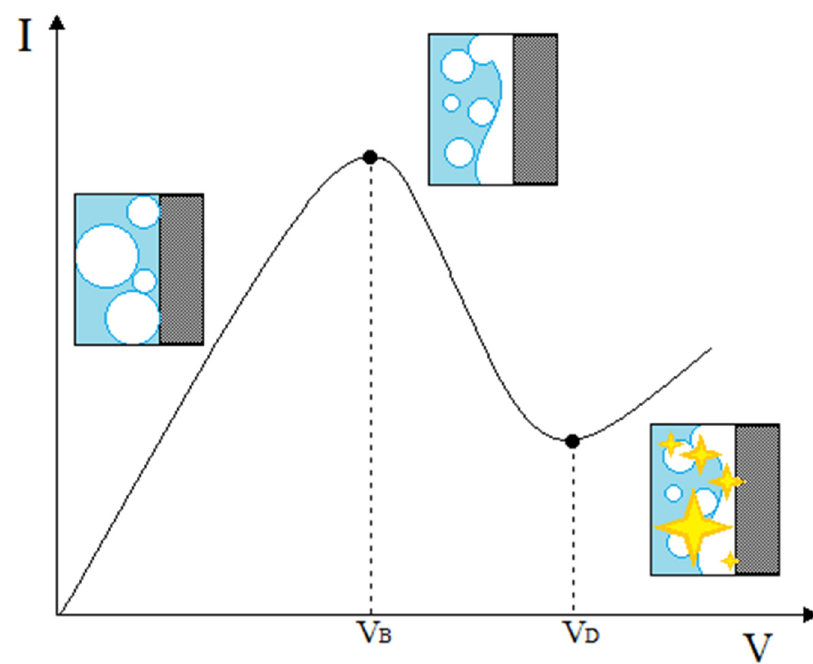
Figure 1. Individuation of V B and V D in a typical current–voltage characteristic curve of a contact glow discharge electrolysis (CGDE) experiment. From zero to V B voltage, the electrolysis proceeds with the current increasing in a nonlinear fashion as expected for a faradaic regime. This initial portion of the curve is associated with the formation of gas bubbles. Once the V B value is surpassed, the water vapor (formed because of Joule heating) plus the electrolytic gas coalesce to form a layer surrounding the active electrode. This coalescence causes a sudden drop of current intensity (I) for the increase of the electron transfer resistance at electrode–electrolyte interface. When the applied potential V appl is larger than V D this gaseous layer turns into an electrochemically generated plasma for the occurrence of a local dielectric breakdown.